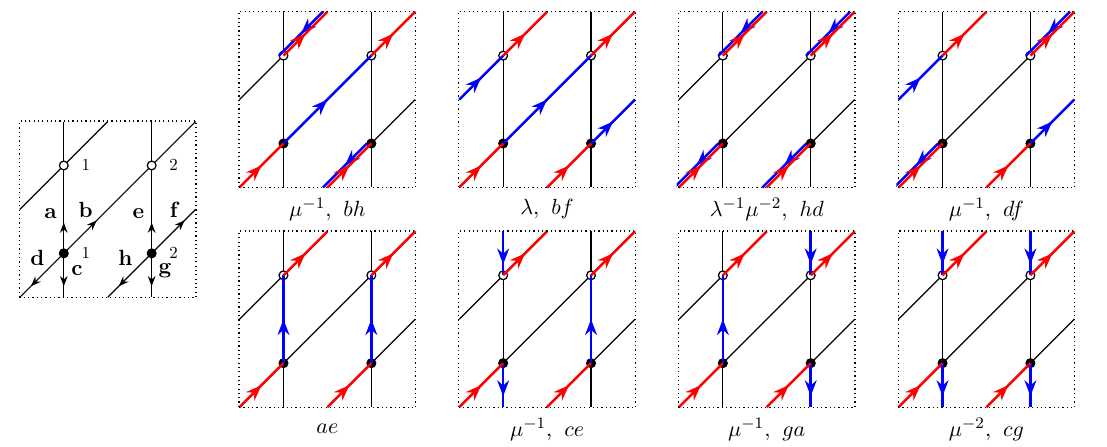
Figure 14 . Left: bipartite graph with the edge weights. Small integers are to enumerate black and white vertices. Right: perfect matchings for bipartite graph from (cid:12)gure 13 are in blue. Red color indicates reference matching D 0 . Weights of the corresponding contributions to determinant of Kasteleyn operator are written